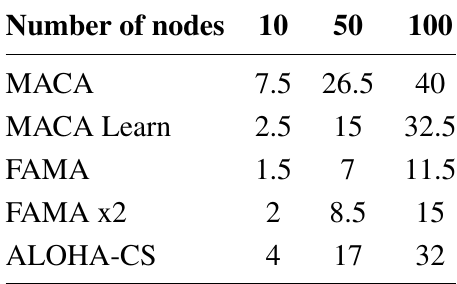
Table 5. Backoff time used in the simulations